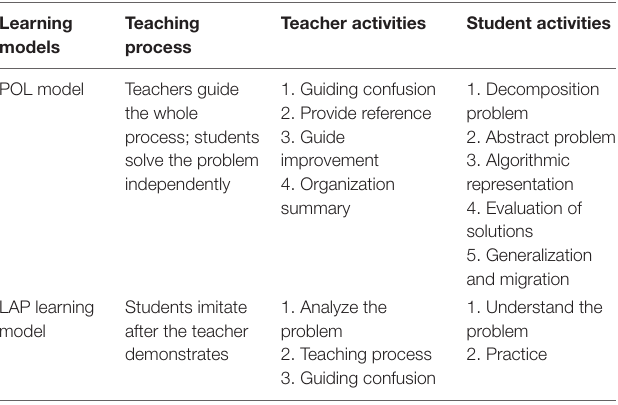
TABLE 2 | The difference between the two learning models.